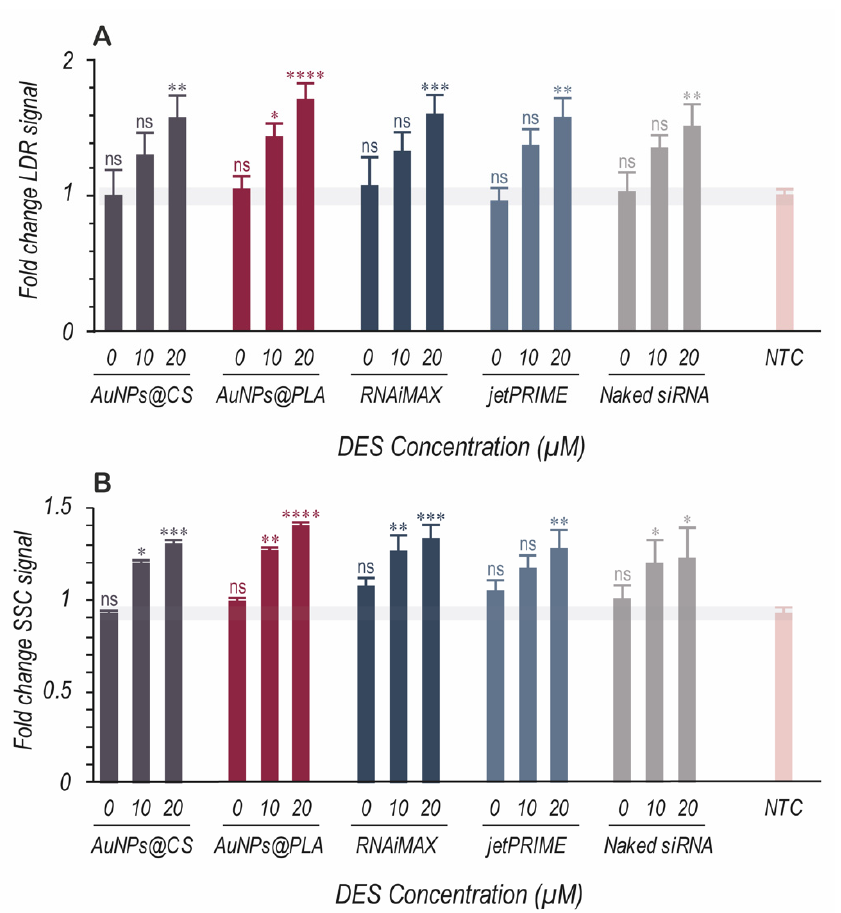
Figure 3. The effect of DES on lysosomal swelling and cellular granularity. ( A ) Fold change in LysoTracker ® Deep Red (LDR) signal and ( B ) Fold change in side scatter (SSC) signal were measured via flow cytometry for NIH-3T3 cells treated 4 h with nanocarriers (30 nM effective concentration of siRNA) followed by 20 h treatment with 3 different concentrations of DES (0, 10, and 20 µM). Data are represented as the mean ± the standard deviation of three independent experiments. Statistical significance, with respect to the not treated control (NTC), is indicated when appropriate (ns = not significant p > 0.05, * p ≤ 0.05, ** p ≤ 0.01, *** p ≤ 0.001, **** p ≤